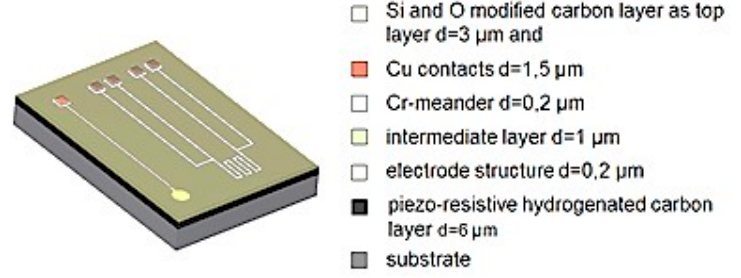
Figure 1. Schematic representation of the layer